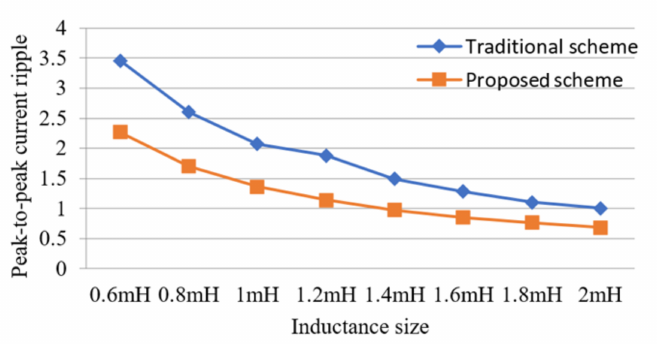
Figure 13. Current ripple with different inductance values.